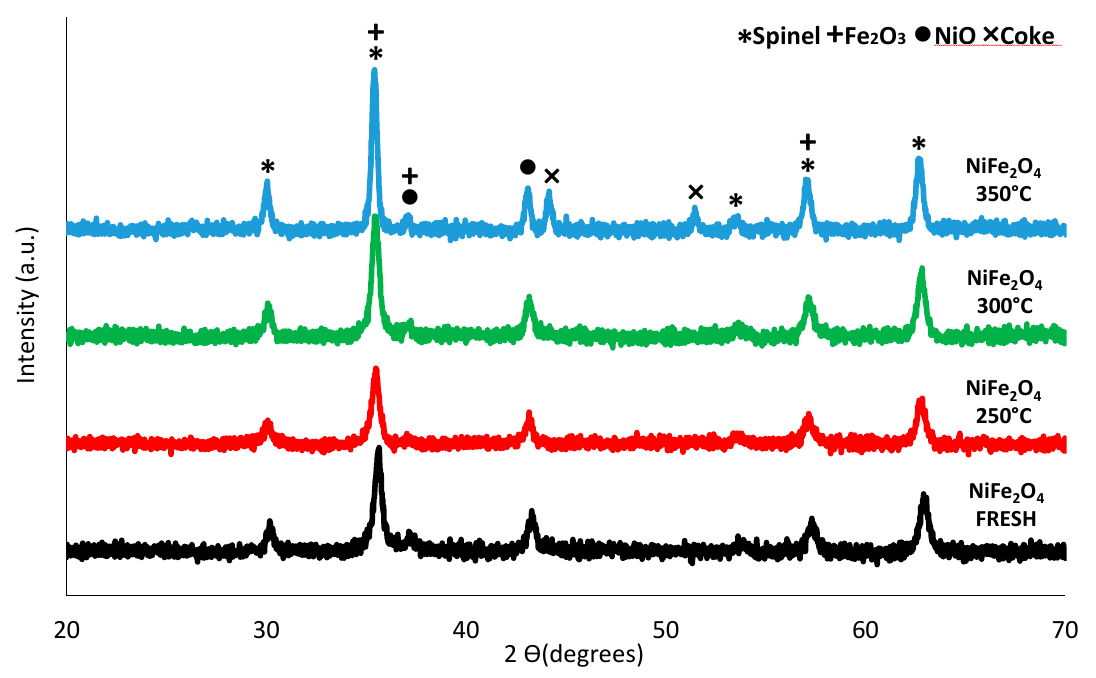
Figure 8. XRD of the fresh and recovered NiFe 2 O 4 .